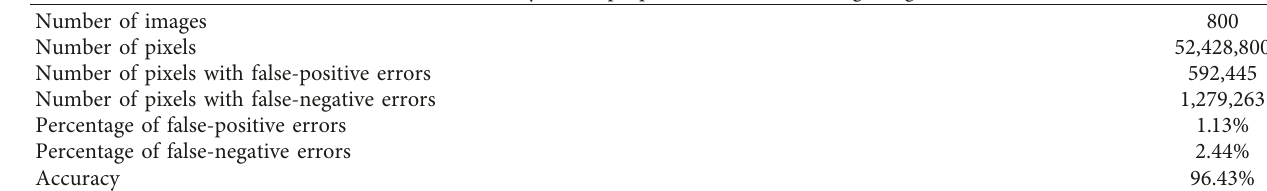
Figure 11: Results of image testing with (a) false-negative error and (b) false-positive error. Table 3: Accuracy of the proposed DCNN on testing